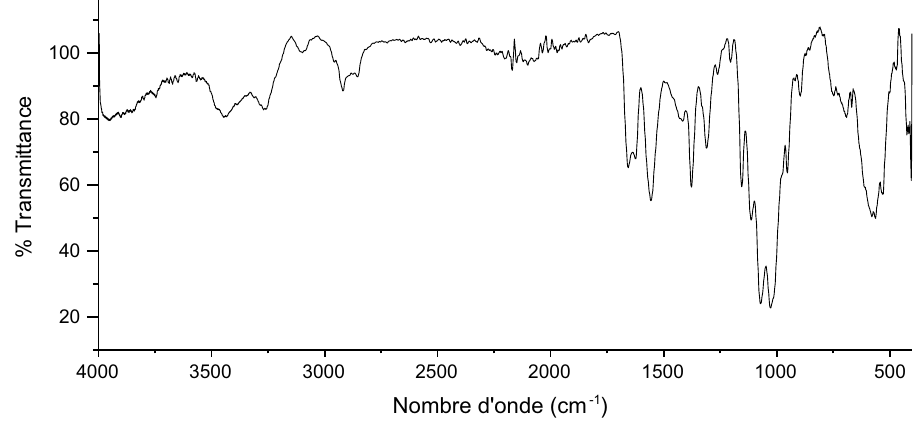
Fig. 1 Infrared spectrum of the chitin crab. Fourier transform infrared (FTIR) spectra of the chitin and their meanings are shown in Table